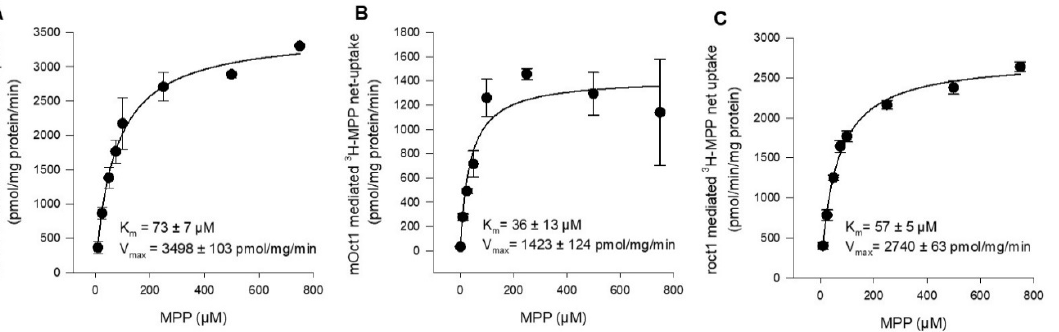
Figure 2. Kinetics of ( A ) hOCT1-, ( B ) mOct1-, and ( C ) rOct1-mediated 3H-MPP transport. Human, mouse, and rat OCT1-transfected HEK293 cells were incubated for 1 min at 37 °C in the presence of labeled (2 nM) and increasing concentrations of non-labeled MPP. Net uptake was fitted to the Michaelis–Menten equation to obtain the affinity constant K m and maximum transport velocity V max by non-linear regression analysis using Sigma Plot 13.0 software. Each data point represents the mean of two independent experiments ± average deviation. Experiments were carried out in triplicates.